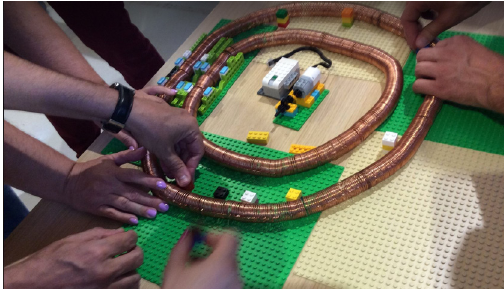
Fig. 2. A collider model made by teachers, “Playing with Protons”,